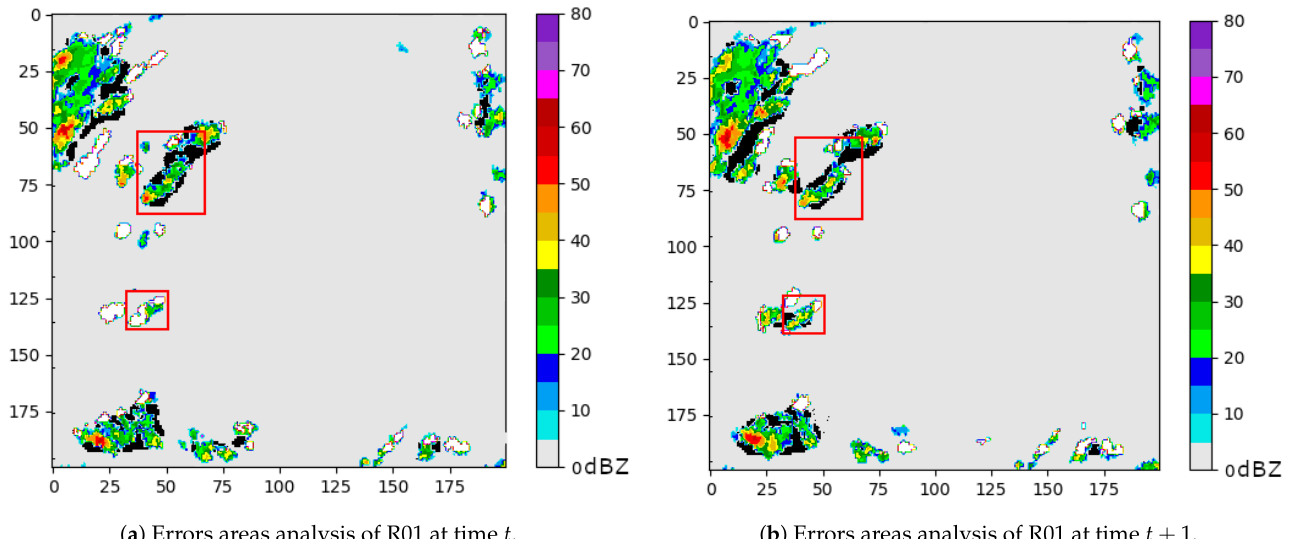
Figure 5. Visualization of AutoNowP errors areas analysis for two consecutive time steps. In white are the areas where the model usually predicts false negatives and in black are areas where the model usually predicts false